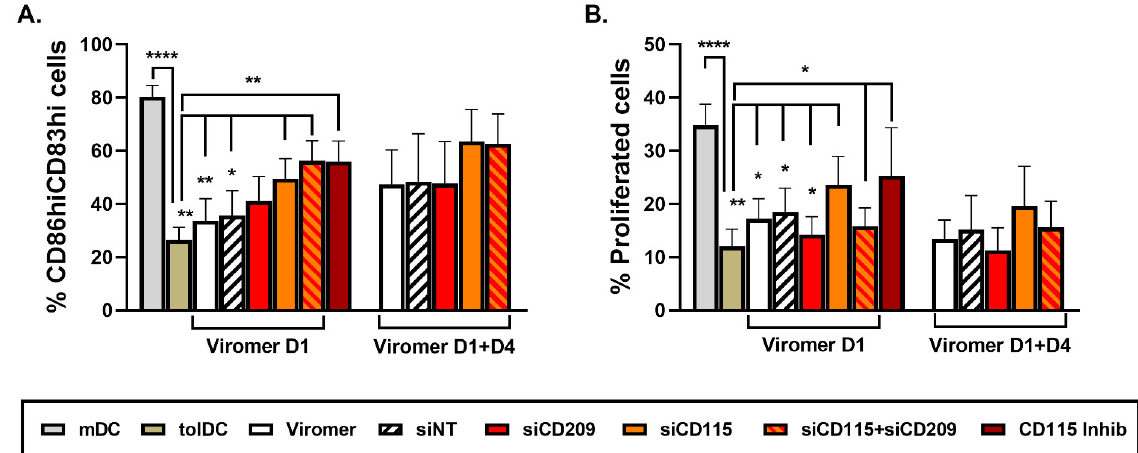
Figure 4. CD115 down-modulation partially alters phenotype and functionality of VitD3-tolDC. Analysis of phenotype (% CD83 hi CD86 hi cells) ( A ) and functionality (ability to induce allogeneic PBMC proliferation using a ratio of DC/PBMC of 1/20) ( B ) of VitD3-tolDC treated with CD115-siRNA and/or CD209-siRNA on day 1 (D1) or on day 1 + day 4 (D1 + D4) of culture. In addition to controlling transfection conditions (Viromer and siNT), cells also treated on day 0 + day 4 with a specific CD115-inhibitor (PLX5622) were included. Data shown as mean + SEM. For mDC and VitD3-tolDC, n = 8; for conditions of transfection with Viromer on D1, n = 6; and for conditions of transfection with Viromer on D1 + D4 and for CD115 Inhibitor, n = 3. * p < 0.05; ** p < 0.01; **** p < 0.0001.